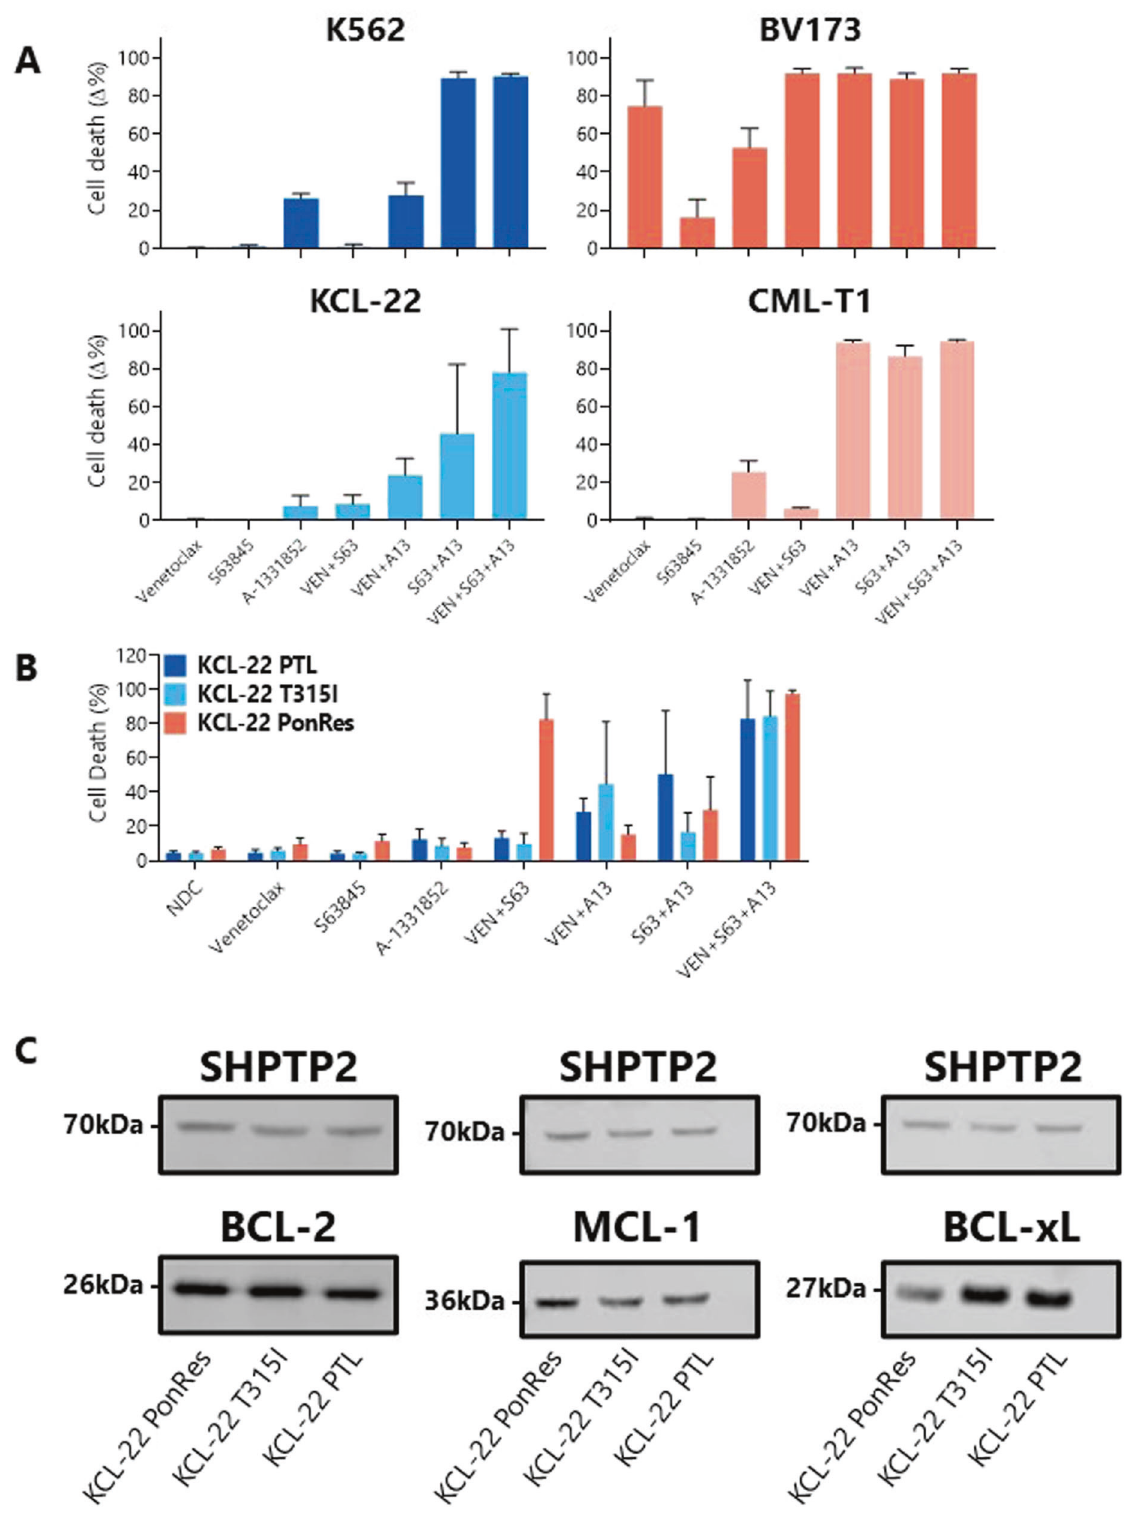
Fig. 3 Combining BH3 mimetics in BP-CML cell lines induces a greater degree of apoptosis than single treatments. Parental ( A analyzed by one-way ANOVA) and TKI-resistant ( B two-way ANOVA) BP-CML cell lines were treated with 250 nM indicated BH3 mimetic for 72 h before Annexin V/DAPI staining by fl ow cytometry, N = 3. Signi fi cant differences can be seen in Supplementary Tables 4 and 5. Basal protein expression of BCL-2, MCL-1, and BCL-xL were measured by Western blot ( C ), with a representative blot for each protein shown, N = 3. Full